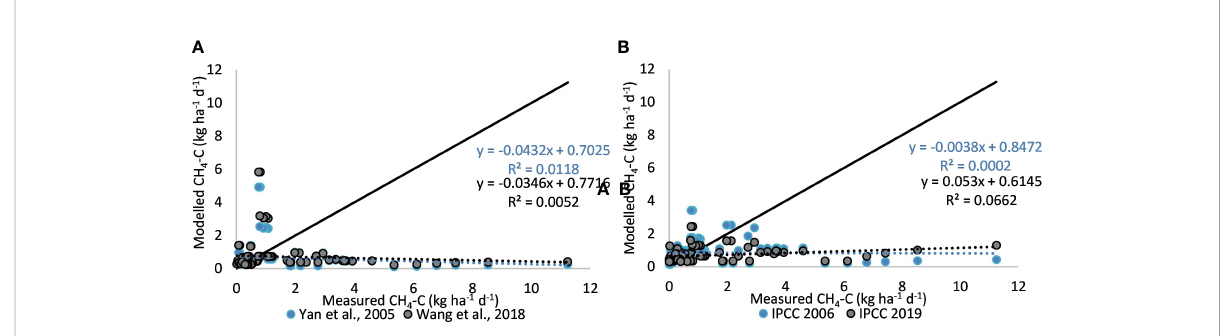
FIGURE 4 Modelled and observed CH 4 emission for South Asia: (A) Yan and Wang tier 3 models, (B) IPCC tier 1 models (solid line indicates 1:1). Sample size n = 103 for tier 3 models and 117 for tier 1